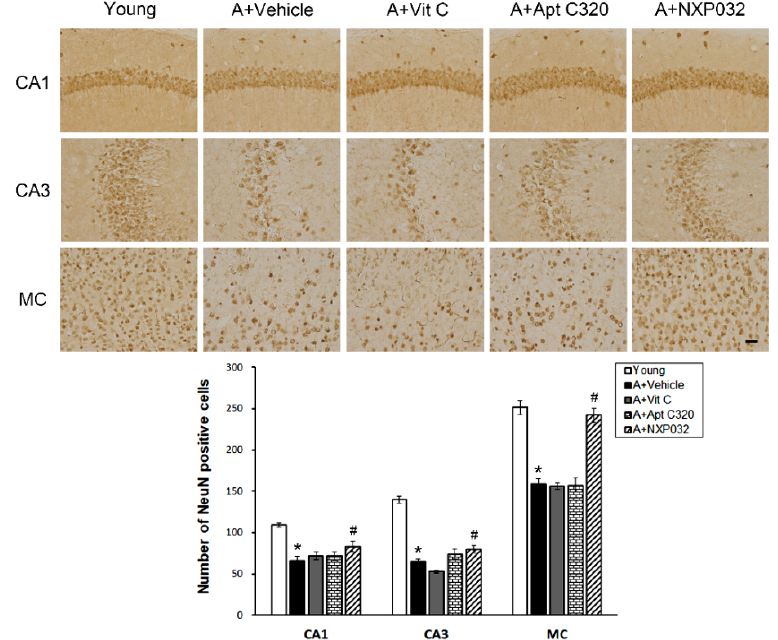
Figure 2. Effect of NXP032 on aging-induced neuronal cell death in the brain. Representative photographs of immunostaining of NeuN-positive cells in the hippocampal CA1, CA3, and MC regions. The aging mice had a significantly reduced number of NeuN-positive cells in the hippocampal CA1, CA3, and MC regions compared to the young mice. NXP032-treated mice had a significantly higher number of NeuN-positive cells in the hippocampal CA1, CA3, and MC regions than vehicle-treated mice. In the vit C and Aptamin 320-treated groups, the number of NeuN-positive cells did not increase in hippocampal CA1, CA3, and MC regions. The data are presented as the mean ± S.E.M. * p < 0.05, compared to the young group. # p < 0.05, compared to the aging-vehicle group. Scale bar: 50 µm.